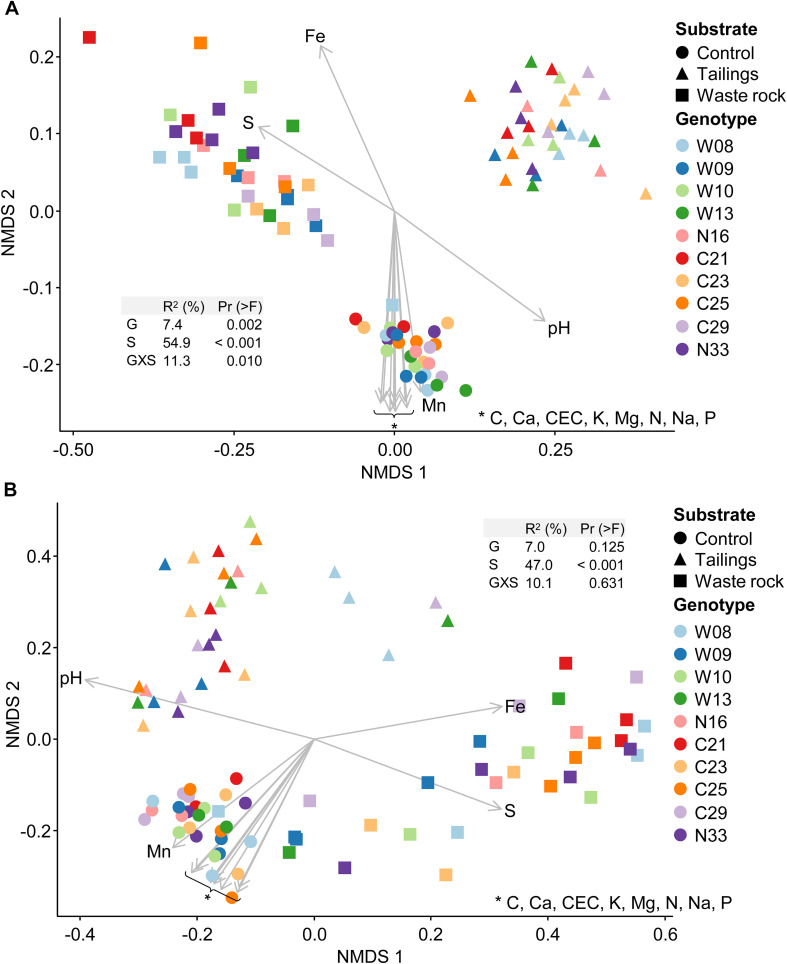
Non-metric multidimensional scaling (NMDS) ordination of variation in bacterial and fungal community structure of balsam poplar rhizosphere in the greenhouse experiment. Bacterial community (A) and fungal community (B). Points represent samples and arrows represent the significant (p < 0.001) correlations between NMDS axes and the physicochemical properties of the substrates. In PERMANOVA tables, G is for genotype; S for substrate type and GXS for the interaction between genotype and substrate type. The model explains 73.6 and 64.1% of the variation in bacterial and fungal community structure, respectively (n ≥ 3).